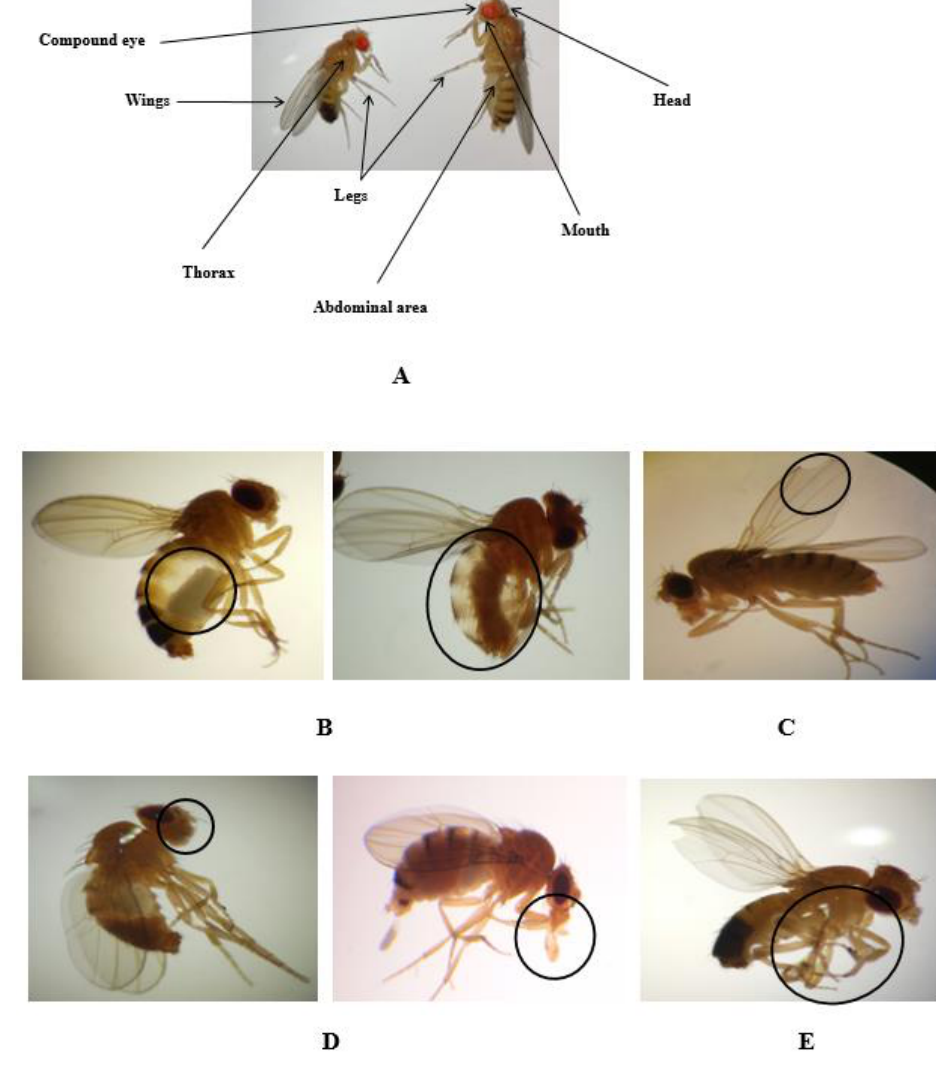
Figure 2. Adult morphology of Drosophila ( A ). Morphological alterations in the abdomen ( B ), wings ( C ), mouth ( D ), and legs ( E ) of adult D. melanogaster observed in permethrin (0.1 mM), permethrin nanopesticides (2.5 mM), acephate and acephate nanopesticides (5 mM), and validamycin and validamycin nanopesticides (2.5 mM). Black circles indicate the defective area in the image.